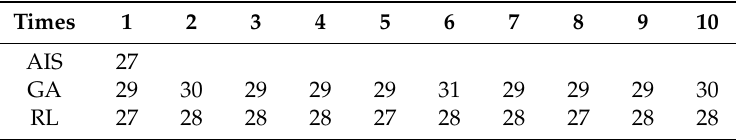
Table 2. The comparison of optimal results for 10 times (min).